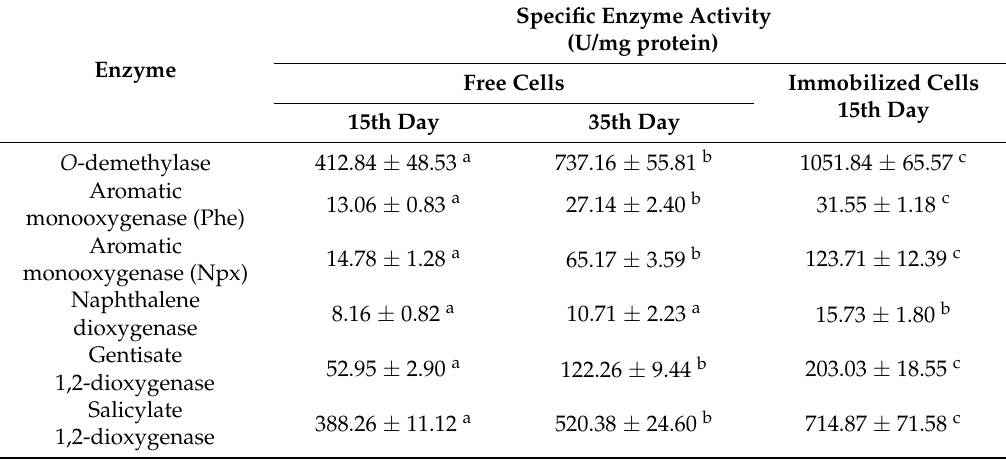
Table 4. Specific activity of enzymes involved in naproxen degradation under cometabolic conditions by immobilized and non-immobilized Planococcus sp. S5. Different letters (a, b, c) indicate a statistically significant difference between activity of enzymes from free and immobilized cells ( p ≥